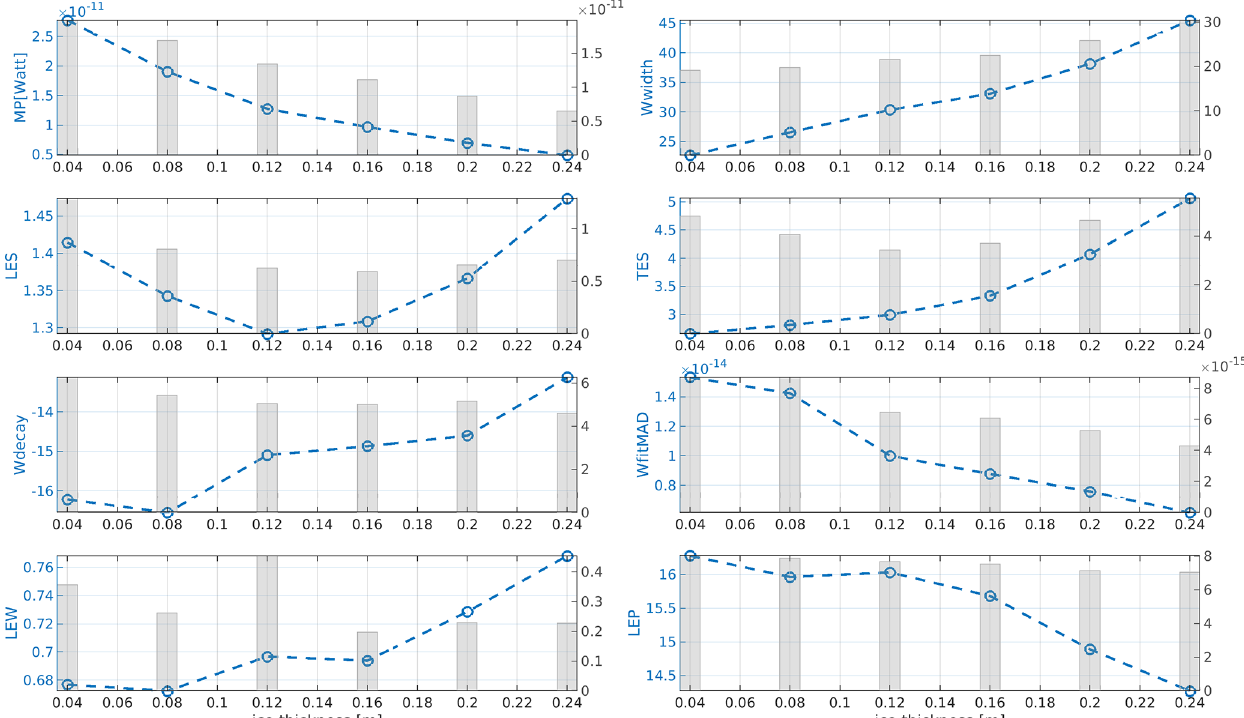
Figure 7. Waveform-derived shape and power features from an unsupervised classification plus two external features of leading-edge width (LEW; Hendricks et al., 2021) and leading-edge peakiness (LEP; Ricker et al., 2014) with respect to different TIT categories. Shown are the averaged feature values (blue dotted circles) and the corresponding standard derivation (grey bar) per TIT groups of ± 2cm from 2 to 25cm. Abbreviations of waveform features used in classification are explained in Fig.